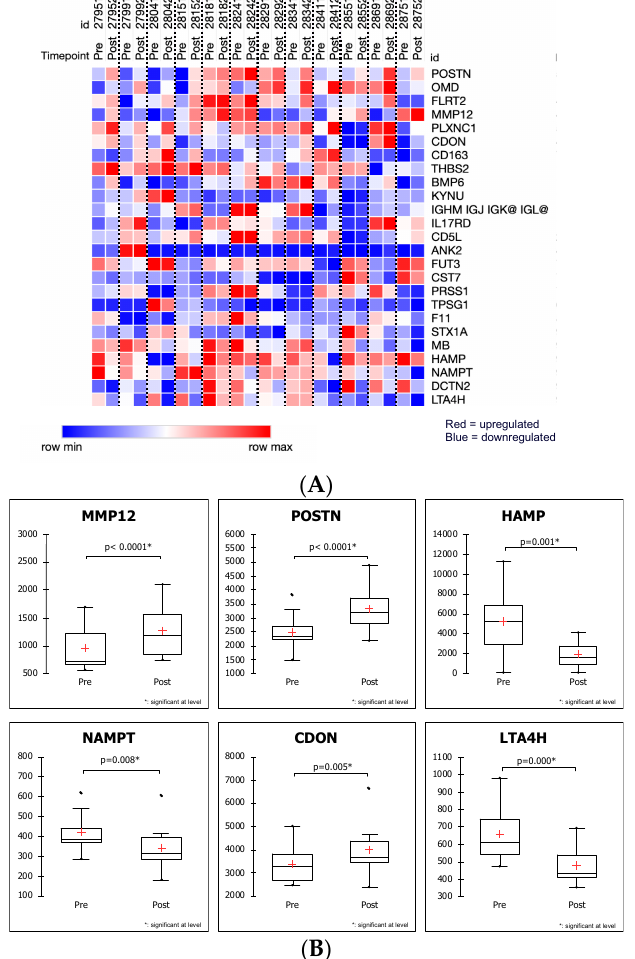
Figure 2. ( A ). Heat map of 25 proteins differentially expressed ( p < 0.01) in the preoperative and postoperative states, as shown by patient. In the colormap, red denotes upregulation and green denotes downregulation. ( B ). Box Whisker plots of the selected top